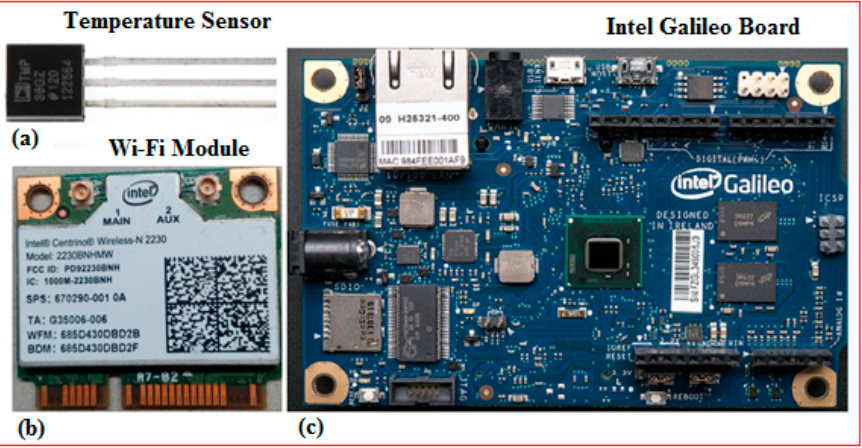
Figure 1. The components for the sensor node: ( a ) temperature Sensor; ( b ) Wi-Fi Module (N-2320); ( c ) Intel Galileo Board.